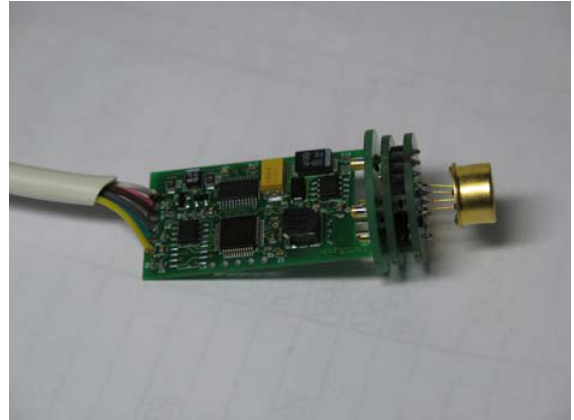
Figure 6. Smart sensor unit with gas sensor in TO-8 packaging. The round board is a smart unit with UART interface enabling temperature control of the sensor and providing all information about concentration of gas, type of sensor, enabling compensation of ambient humidity, etc. Diameter of this board is of 25